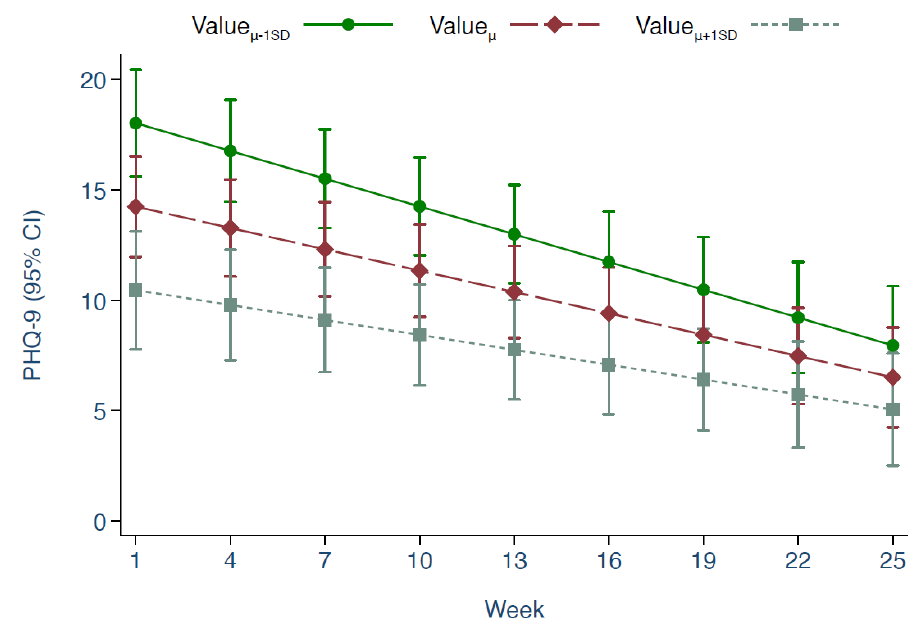
Figure 2. PHQ-9 predicted by valued action. Note. Lines depict estimated PHQ-9 scores at mean, and 1 SD above and below, of valued action for the sample over the study period; error bars depict 95% CIs of the